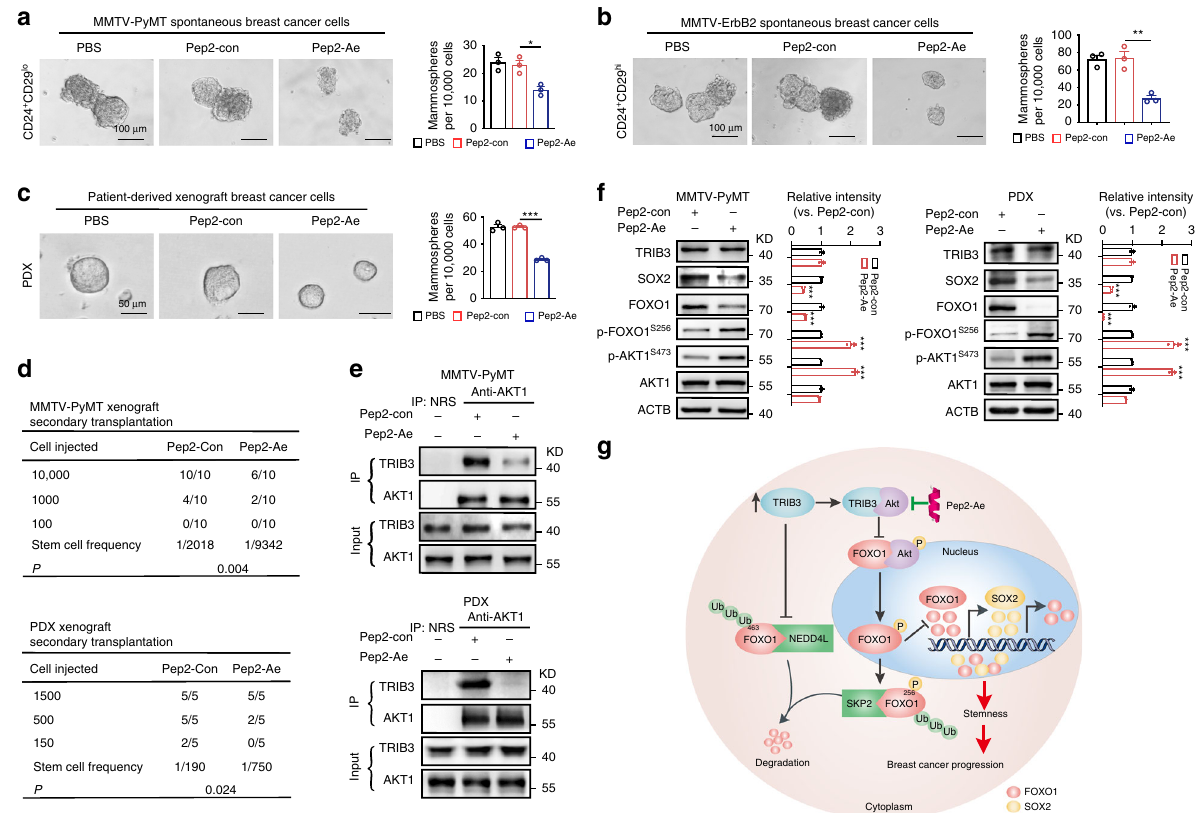
Fig. 8 Pep2 – Ae disturbs the TRIB3-AKT interaction and reduces breast cancer stemness. a – c Pep2 – Ae suppressed mammosphere formation. Primary MMTV-PyMT, MMTV-ErbB2, and PDX BCCs were cultured in tumorsphere media and treated with the indicated peptides (1 μ M) for 5 – 7 days. The size and number of mammospheres were analyzed (scale bar, 100 μ m or 50 μ m). d The effects of Pep2 – Ae treatment on the tumor incidence of secondary transplanted MMTV-PyMT-derived breast cancer in FVB/N mice (top) and PDX-derived BCCs in NPG mice (bottom). e The effect of Pep2 – Ae on the TRIB3/AKT1 interaction. Primary MMTV-PyMT and PDX BCCs were isolated from peptide-treated engrafted mice. Cell extracts were IP with an anti-AKT1 Ab and blotted with an anti-TRIB3 Ab. f The effect of Pep2 – Ae on the levels of the indicated proteins. Primary MMTV-PyMT and PDX BCCs were isolated from peptide-treated engrafted mice. Cell extracts were prepared, and the levels of the indicated proteins were detected by immunoblotting. g Schematic diagram illustrates the elevated TRIB3 expression promoted BCSCs and breast cancer development. Data are shown as the mean ± SEM; P > 0.05 was considered not signi fi cant (NS); * P < 0.05, ** P < 0.01, and *** P < 0.001 compared with Pep2 – con. Source data are provided as a Source Data fi physiological conditions. However, TRIB3-enhanced SOX2 can bind to the FOXO1 promoter, to further enhance FOXO1 gene